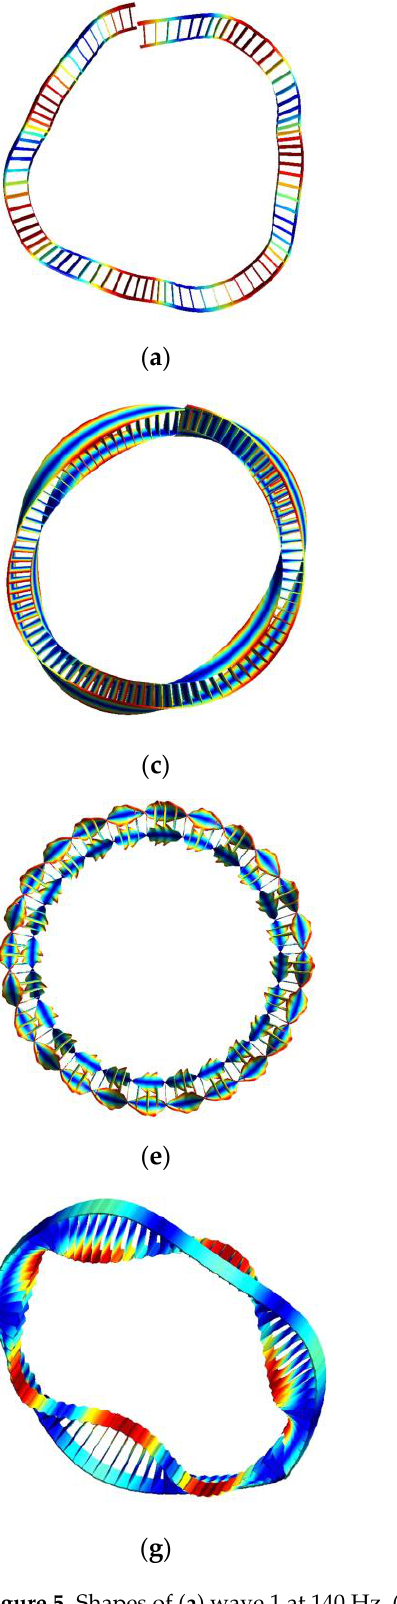
Figure 5. Shapes of ( a ) wave 1 at 140 Hz, ( b ) wave 2 at 5000 Hz, ( c ) wave 3 at 140 Hz, ( d ) wave 4 at 5000 Hz, ( e ) wave 6 at 5000 Hz, ( f ) Wave 5 at 1200 Hz, ( g ) wave 7 at 5000